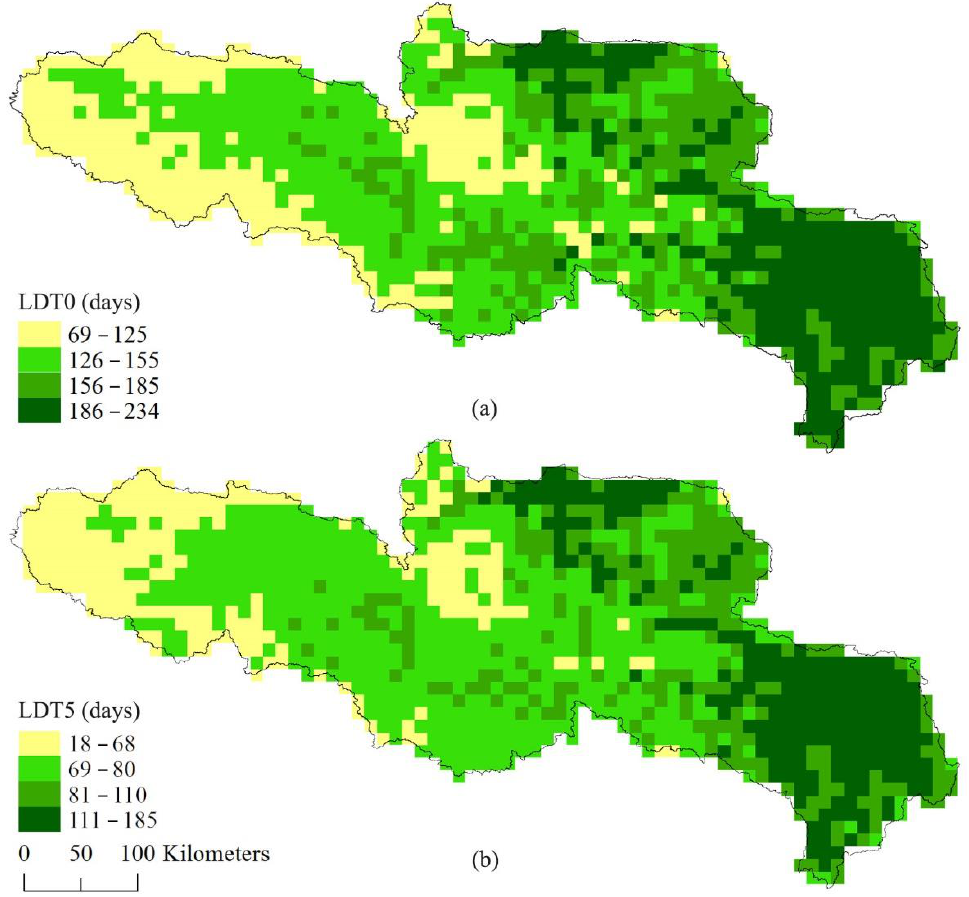
Figure 3. The distribution of the averaged lasting days with mean daily temperature ≥ 0 °C ( a ) and ≥ 5 °C ( b ) during 1979 – 2018 in the source region of the Yellow River.